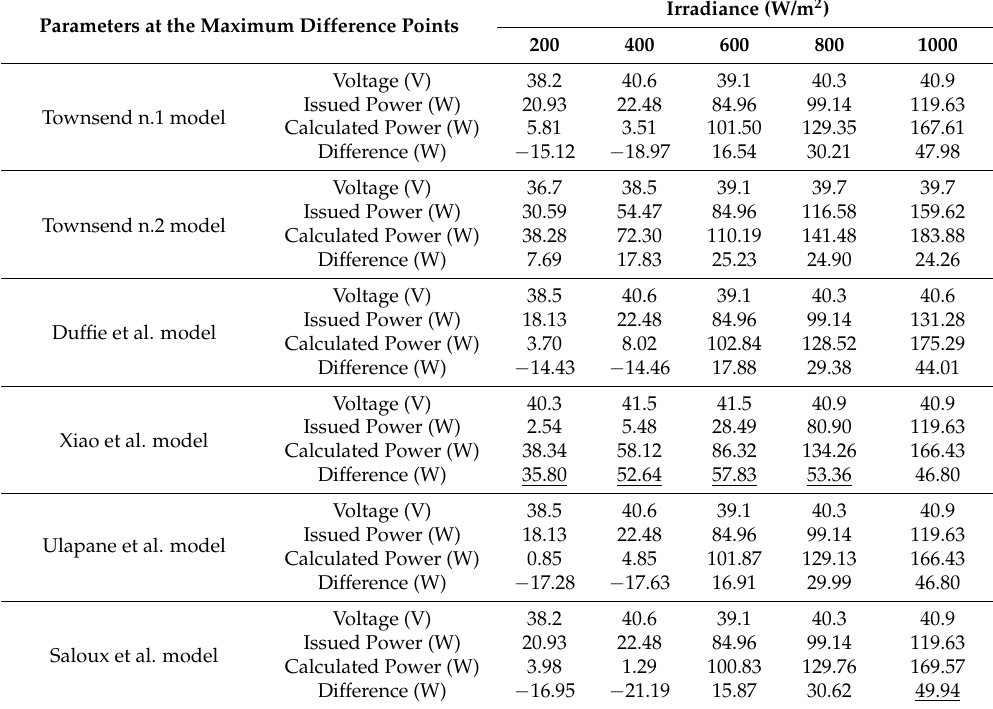
Table 12. Maximum power differences between the calculated and the issued I-V characteristics of Sanyo HIT-240 HDE4, at temperature T = 25 ◦